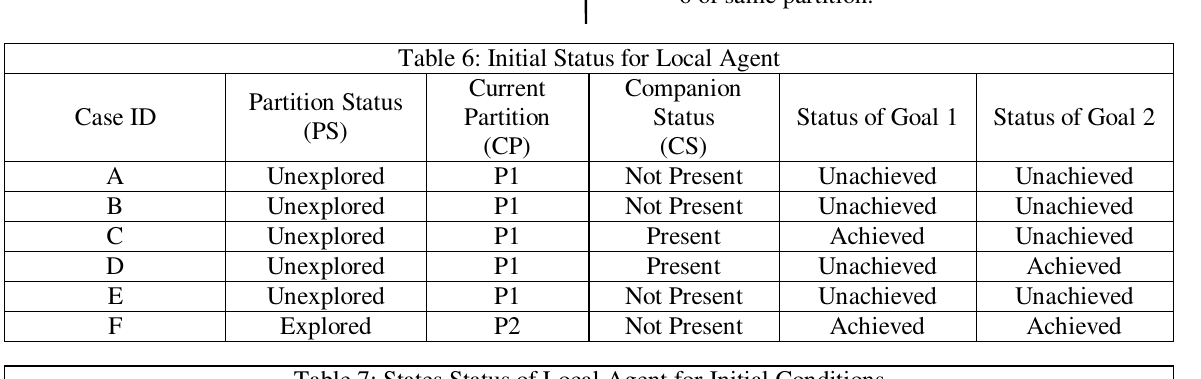
Table 7: States Status of Local Agent for Initial